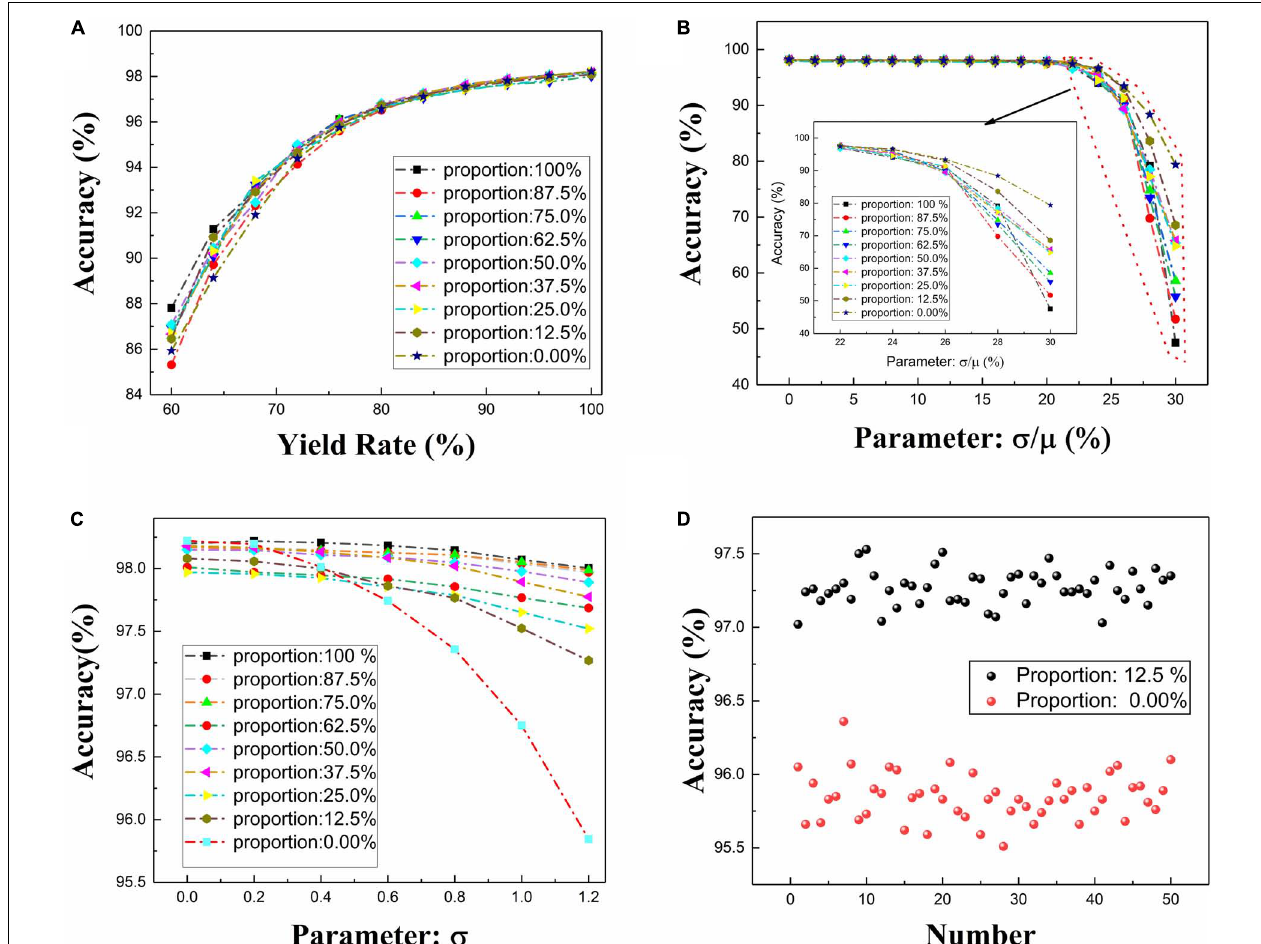
FIGURE 12 | The CFB-CNN architecture with different proportions of neuron configuration with different types of defects existing in memristor array, (A) the impact of the yield ranging from 60 to 100% in memristor array on the CFB-CNN architecture, (B) the impact of memristance variation on the performance of CFB-CNN architecture, (C) the impact of neuron output variation on the CFB-CNN architecture, (D) detailed distribution of test accuracy with the parameter σ being 1.2 and the proportion of the neuron configuration being 12.5 and 0.0%, respectively.